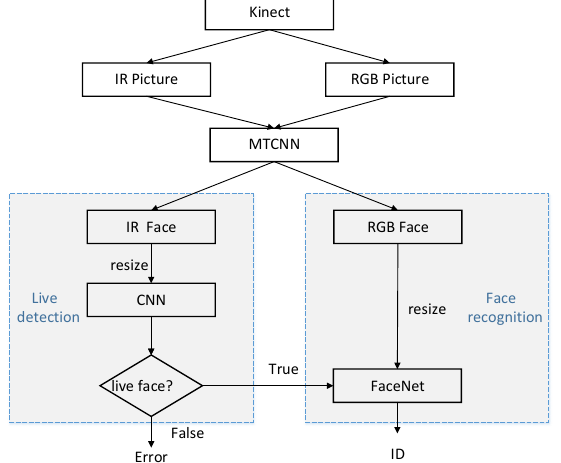
Figure 1. Identity authentication framework based on liveness detection and FaceNet. CNN, convolutional neural network; IR, infrared radiation; MTCNN, multitask cascaded CNN; RGB.